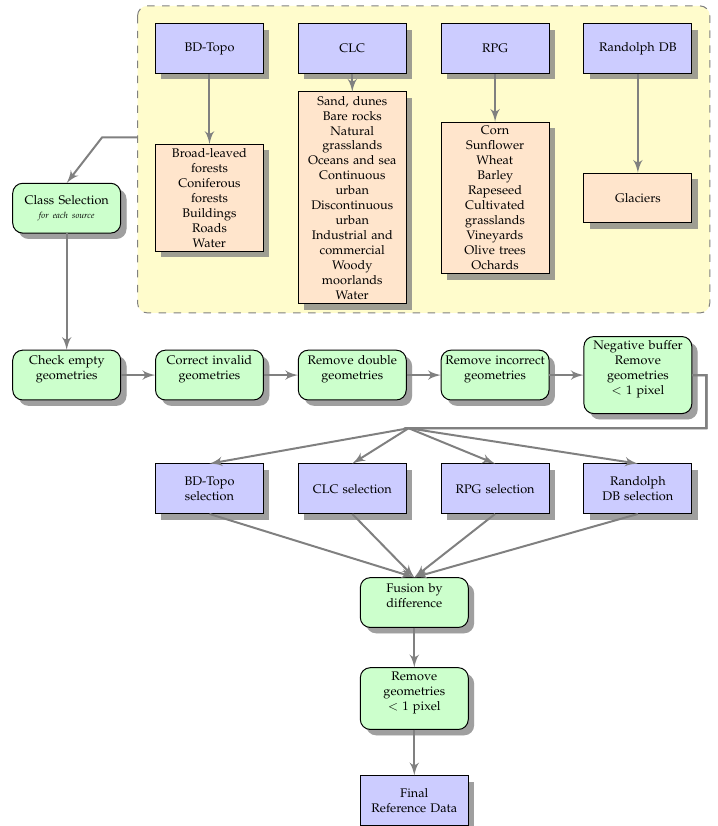
Figure 4. Reference data cleansing.